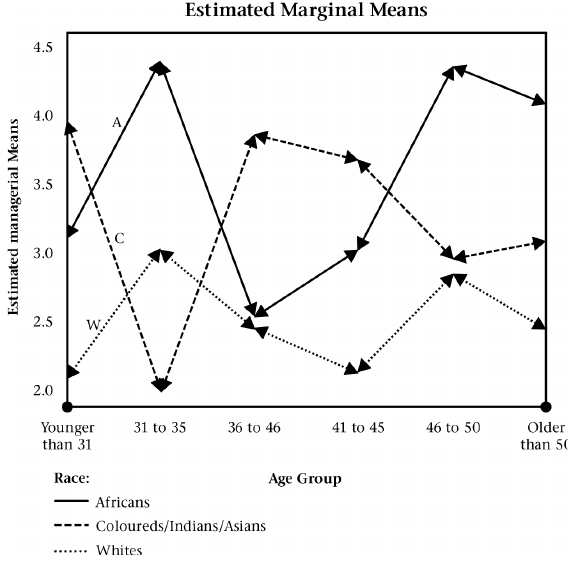
Figure 9:Biographical variables: Age x Race as predictors of the perceptions of black economic empowerment